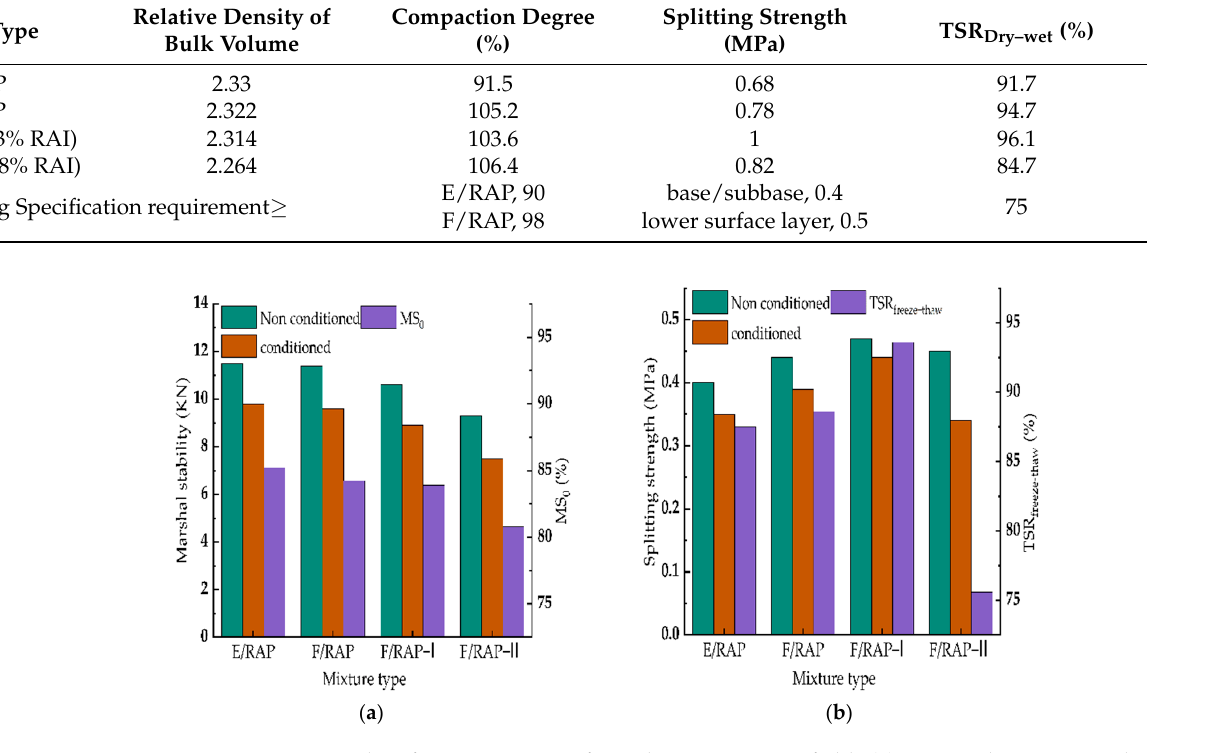
Figure 12. Test results of core specimens from the construction field. ( a ) Freeze–thaw test results. ( b ) Marshall stability test